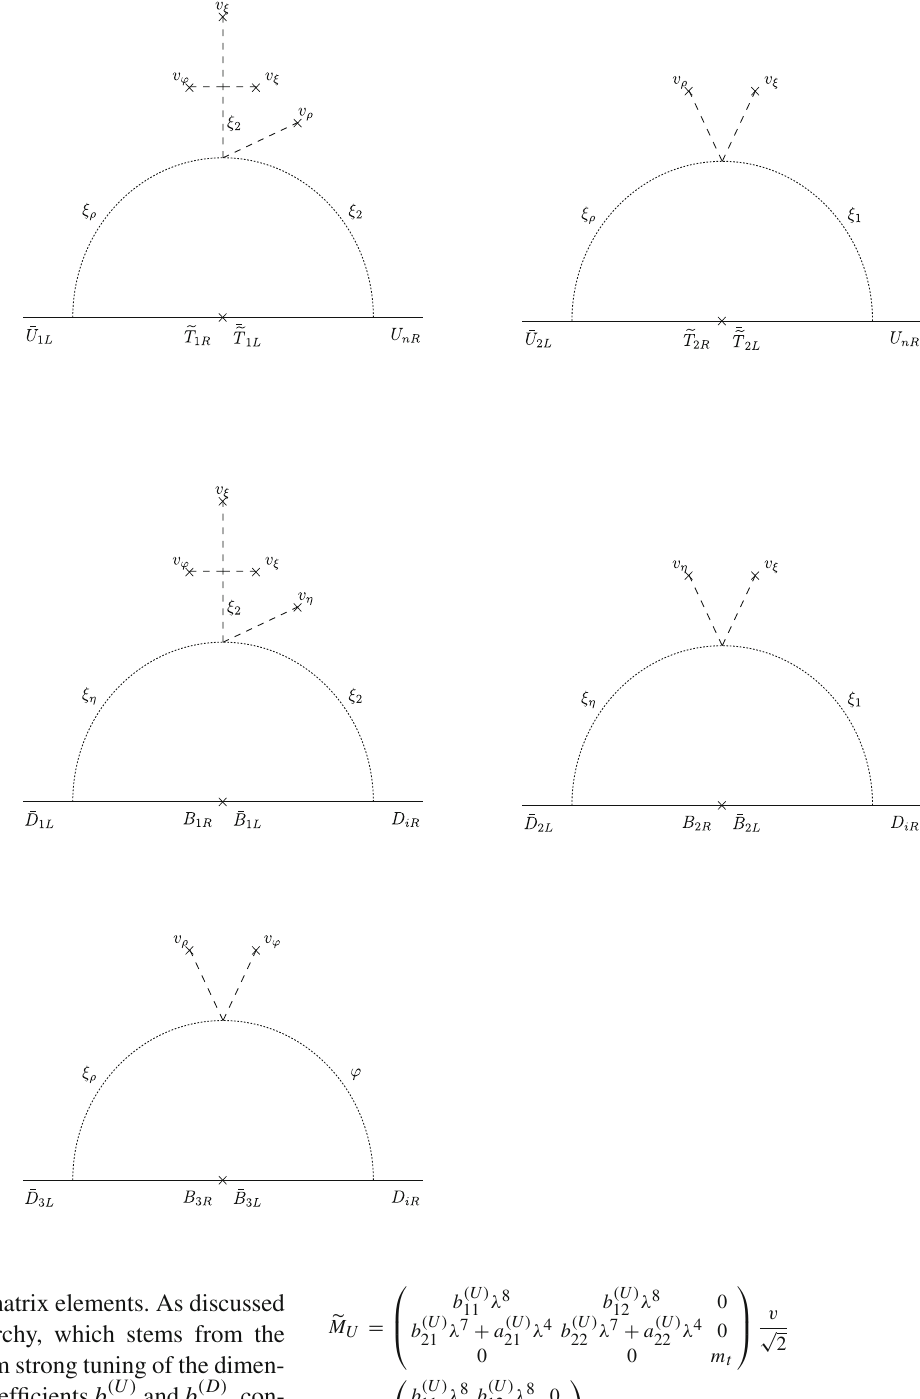
Fig. 3 One-loop Feynman diagrams contributing to the entries of the SM quark mass matrices. Here, n = 1 , 2